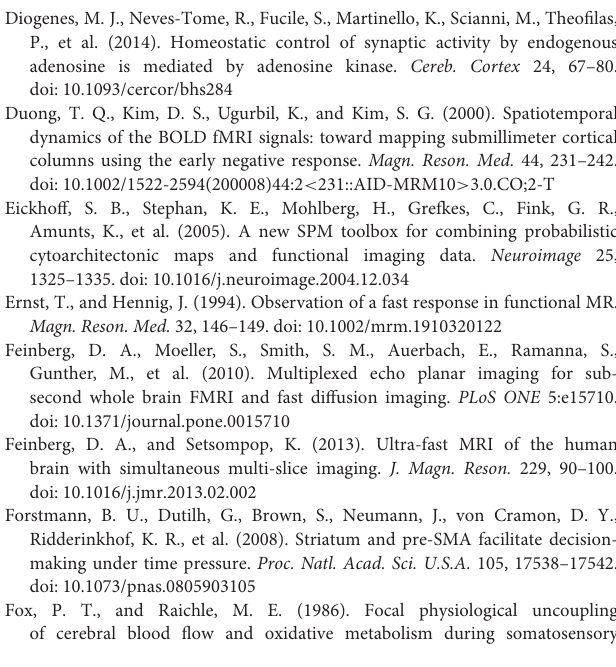
Supplementary Figure 2 | Minority group mean HRFs in specific ROIs. Format is the same as Figure 6 but for the following ROIs: V1, V2, V3, V4, MT, premotor